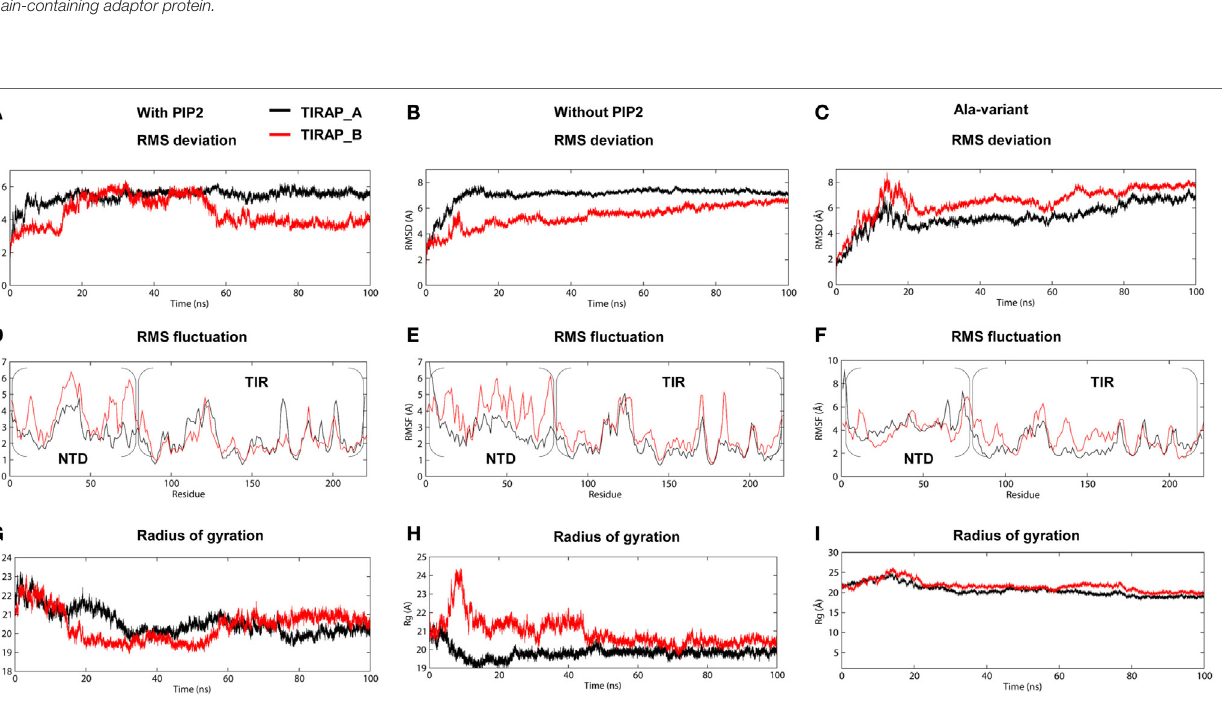
FigUre 3 | Stability parameters of toll/interleukin 1 receptor domain-containing adaptor protein (TIRAP) as a function of simulation time. (a–c) Root mean square deviation; (D–F) root mean square fluctuation; and (g–i) radius of gyration. The left and center columns contain stability parameters for phosphatidylinositol 4,5-bisphosphate (PIP2)-bound and unbound TIRAPs, respectively, while the right column contains stability parameters for a mutant TIRAP (K15 → A, K16 → A, K31 → A, and K32 → A). Also, note that each plot shows parameters for chain (a) (black) and chain (B) (red).